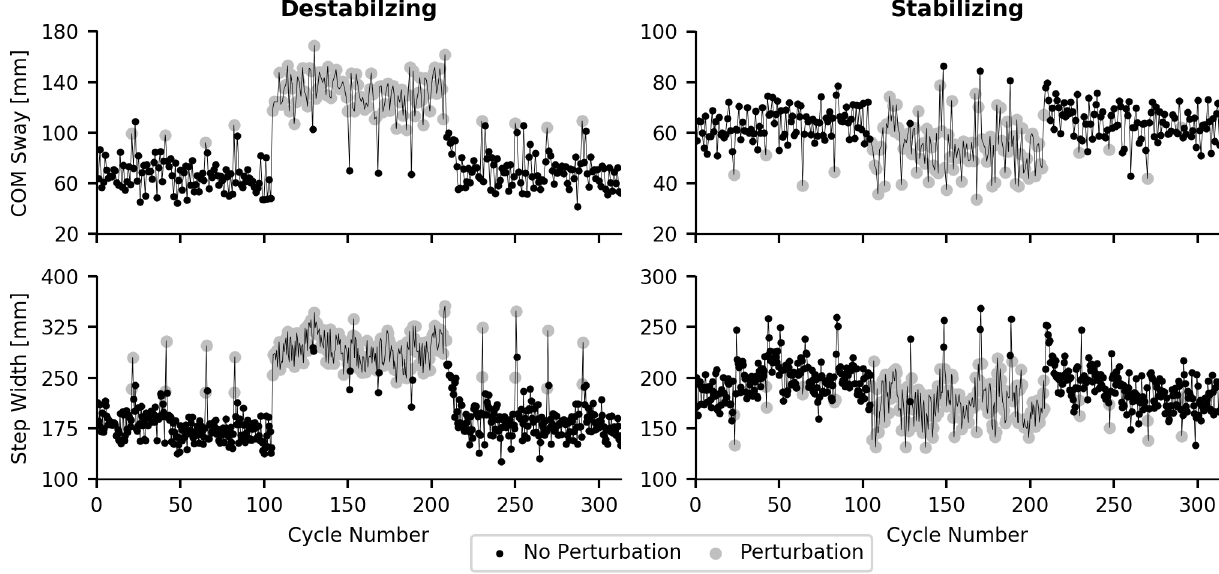
Fig 4. Example response to perturbation from a single participant. COM Sway and step width from a destabilizing perturbation (5%BW no hold) and stabilizing perturbation (2.5%BW no hold) trial. Grey circles indicate perturbation was applied during the gait cycle. Both COM sway and step width increased in response to the accentuating perturbation condition and decreased when perturbations resisting COM movement were applied.